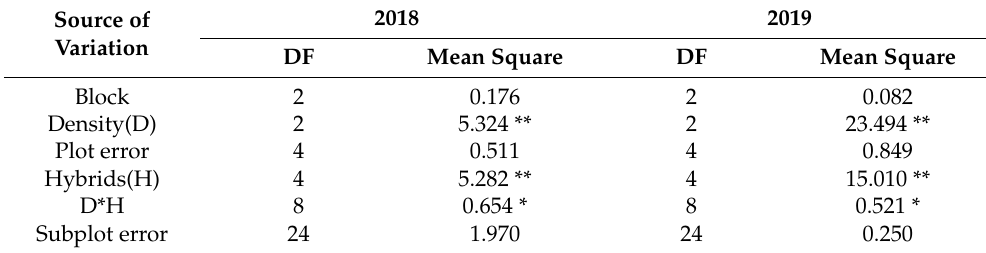
Table 4. Variance analysis of grain water content at harvest stage.